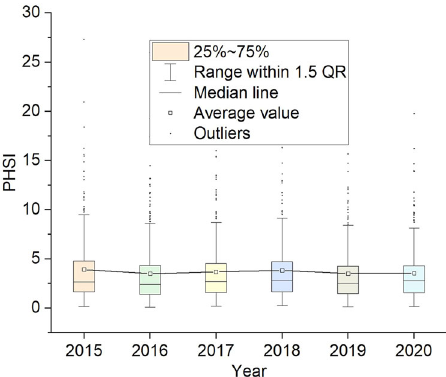
Fig. 3 Time evolution of the pseudo-human settlements index (PHSI).